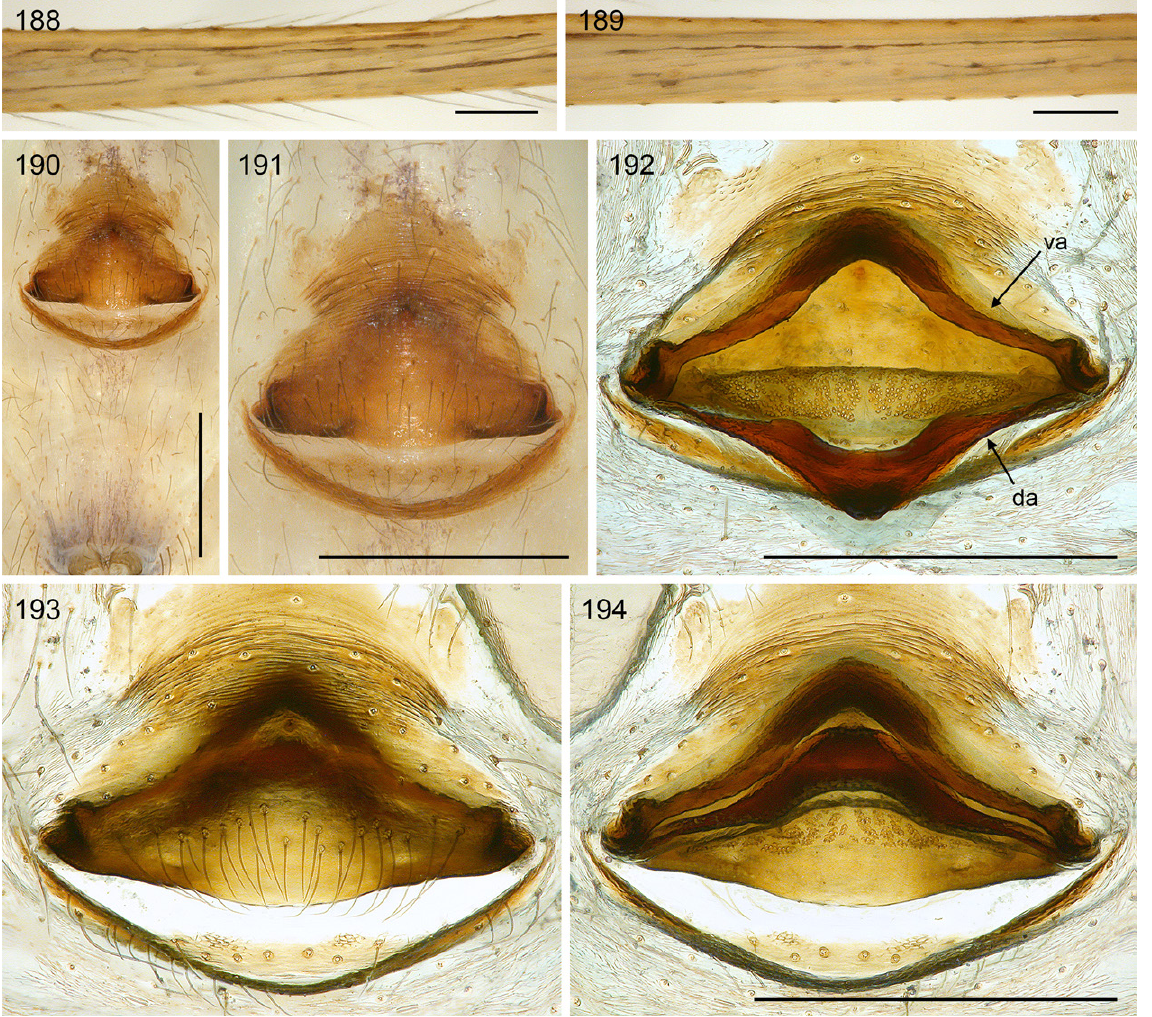
Figs 188–194. Maghreba kahfa gen. et sp. nov.; male and female from Morocco, Agadir, Ifri Taghrart Wankrim (CPO). 188–189 . Male right femora 3 and 4, ventral views. 190–191 . Female abdomen and epigynum, ventral views. 192–194 . Cleared female genitalia, dorsal view with dorsal arc tilted backwards, ventral view, and regular dorsal view. Abbreviations: da = dorsal arc; va = ventral arc. Scale bars: 188–189 = 0.2 mm; 190–194 = 0.5